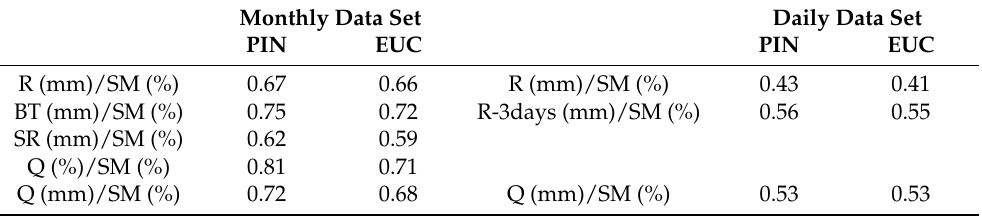
Table 6. Spearman correlation coefficient for average daily soil moisture content (SM) and streamflow (Q); daily antecedent rainfall (R) and rainfall in the 3 antecedent days (R-3days). Pearson correlation for monthly dataset between average soil moisture content and rainfall (mm), streamflow (mm and %), base flow (BT), and surface runoff